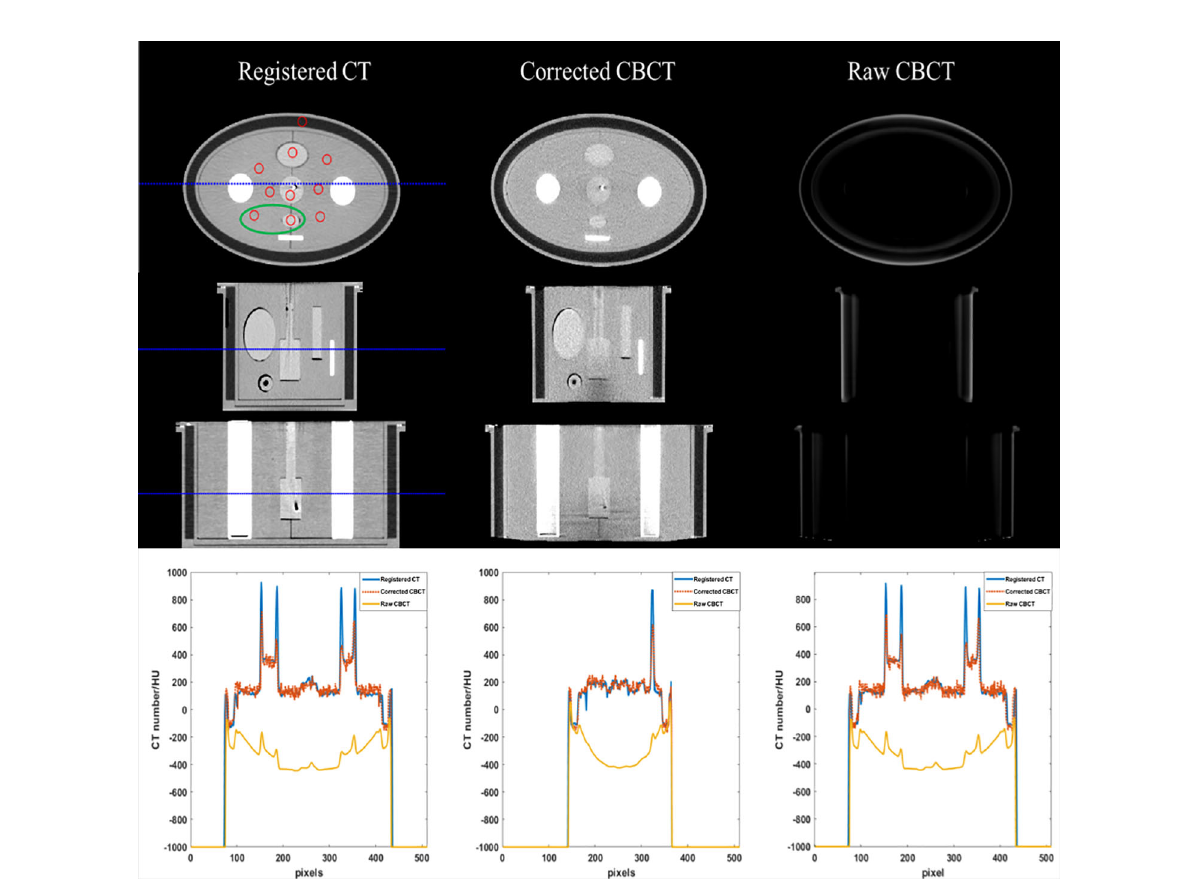
FIGURE 3 CT/CBCT images of the female pelvis phantom. The fi rst three rows display the axial, sagittal, and coronal views from top to bottom; display window: [ − 200 300] HU. The mean CT number and SNU are calculated in the circle areas, and the CNR is calculated in the ellipse area. The 1D pro fi les indicated by the dotted lines are displayed in the last